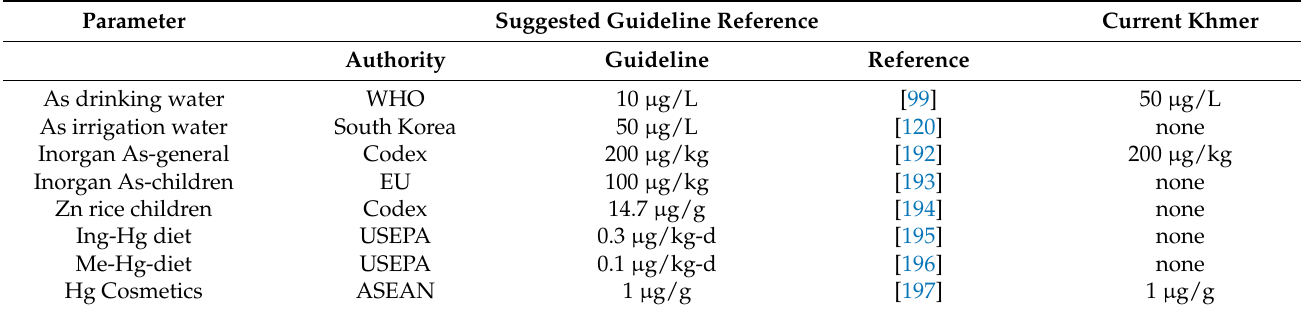
Table 2. Suggested guidelines for better environmental health.